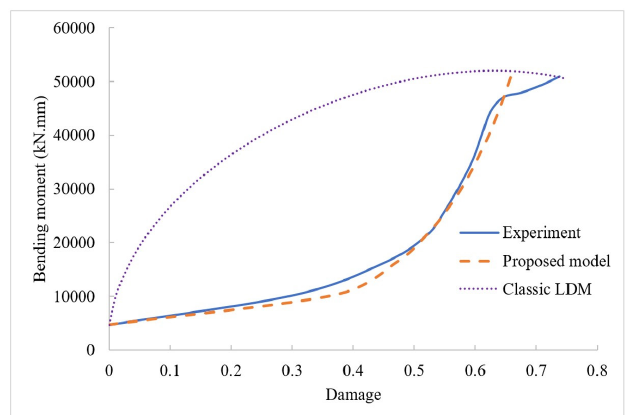
Figure 5. Experimental bending moment vs. damage results from Álvares [31] compared with the classic LDM [26] and the proposed model.